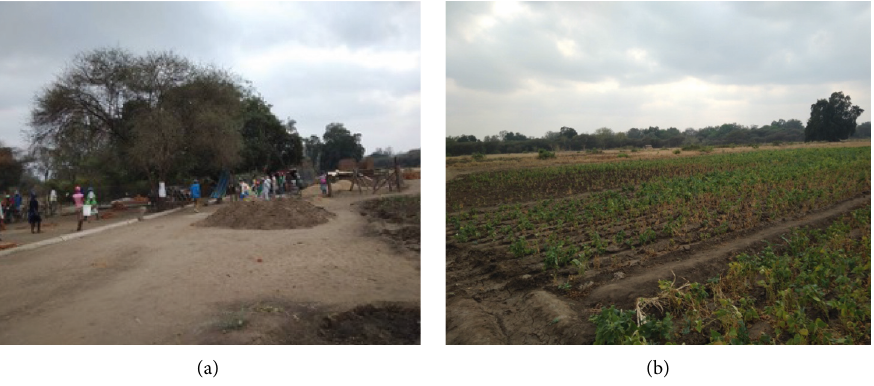
Figure 4: (a) Community members pulling resources together, which includes the human capital to resuscitate Magogogwe irrigation scheme. (b) Wilting legume crops failing at the partially functional Manjinji irrigation scheme. Photo credits: Joseph Antipas,